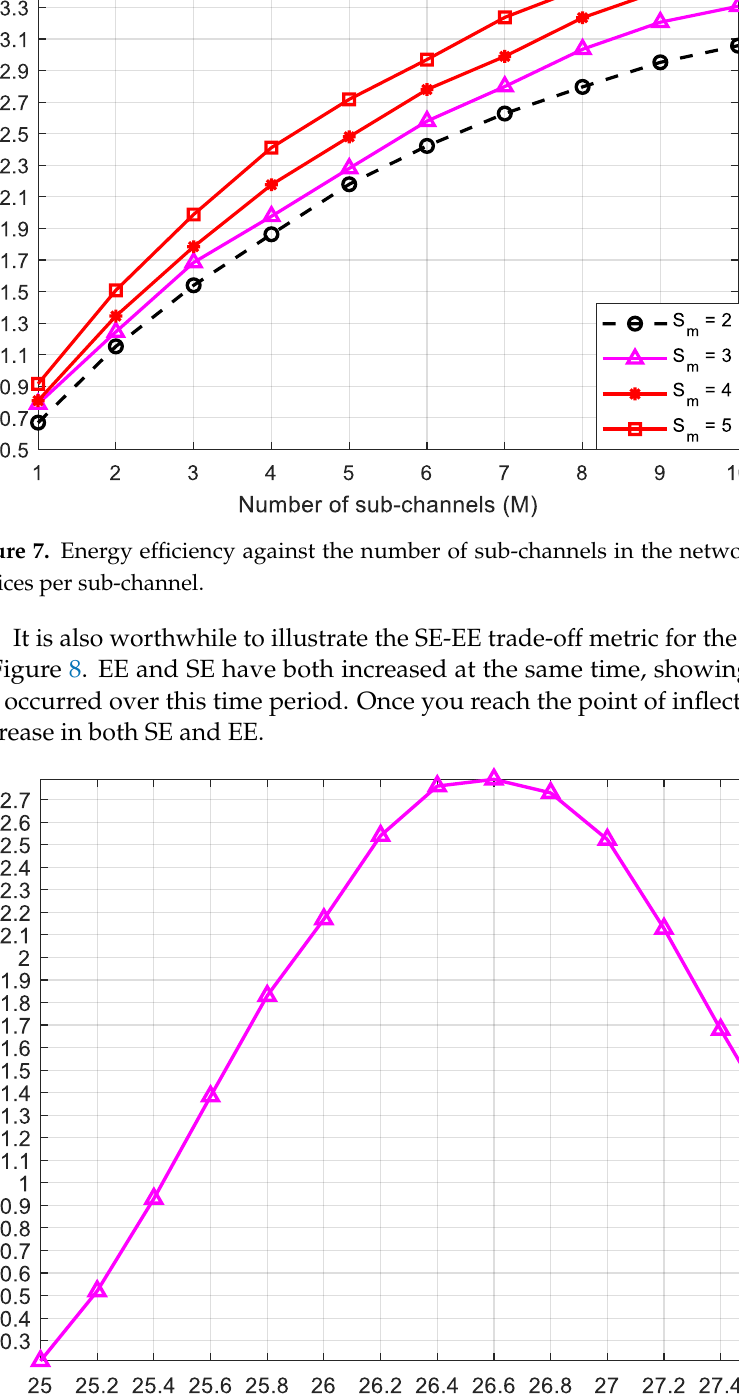
Figure 8. The SE – EE relationship for the proposed system.